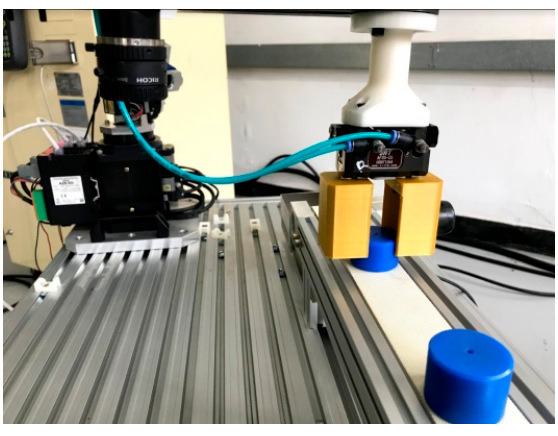
Figure 13. Object picking result.